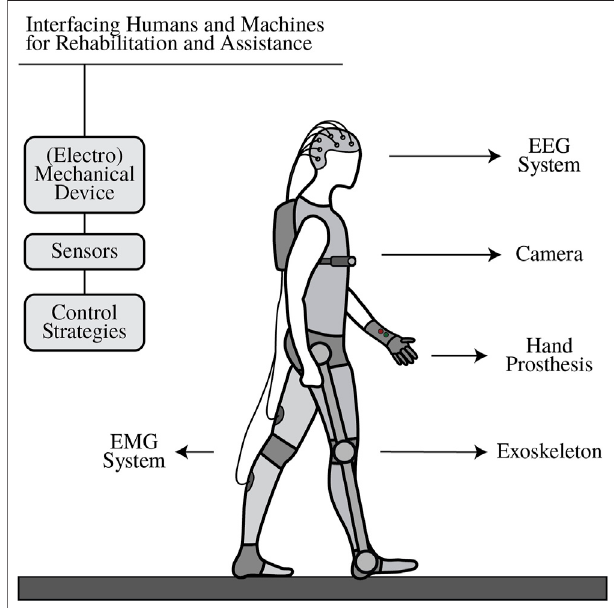
FIGURE 1 | Interfacing humans and machines for rehabilitation and assistive